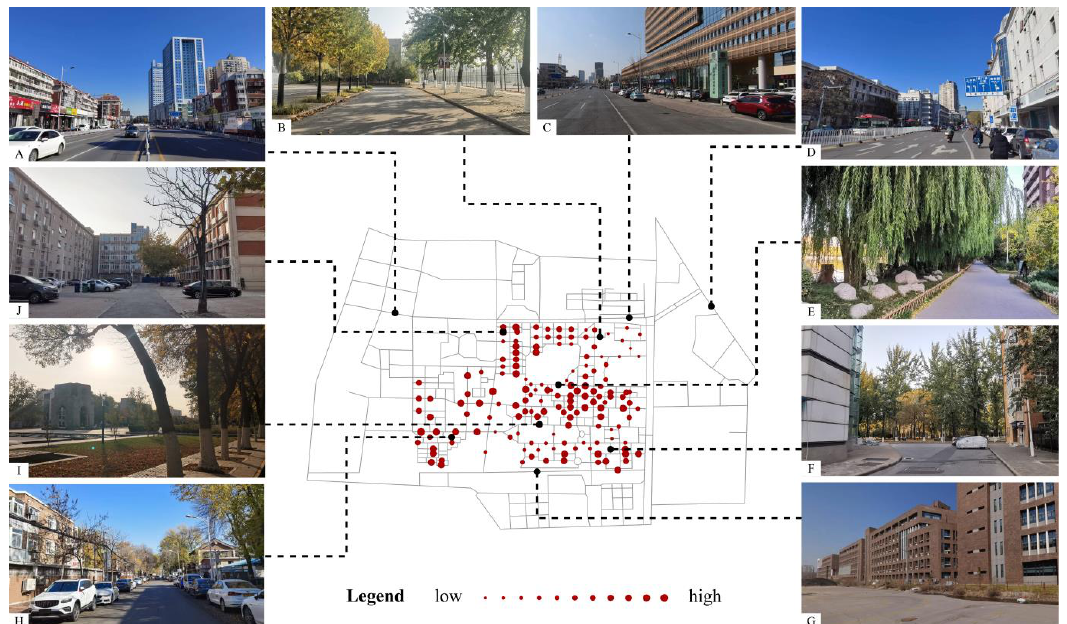
Figure 4. Photo collage illustrating the quality of the street environment. All the photos were taken by the first author. ( A ) West side of the Anshan West Road. ( B ) The east side of Jixian Road. ( C ) The east side of Anshan West Road. ( D ) Xinxing Road. ( E ) The road on the south side of the lake. ( F ) The road in the student residential area on the southeast of the campus. ( G ) The road connecting Tianjin University and Nankai University. ( H ) Hubin Road. ( I ) Jingye Road. ( J ) The west side of Jixian Road.